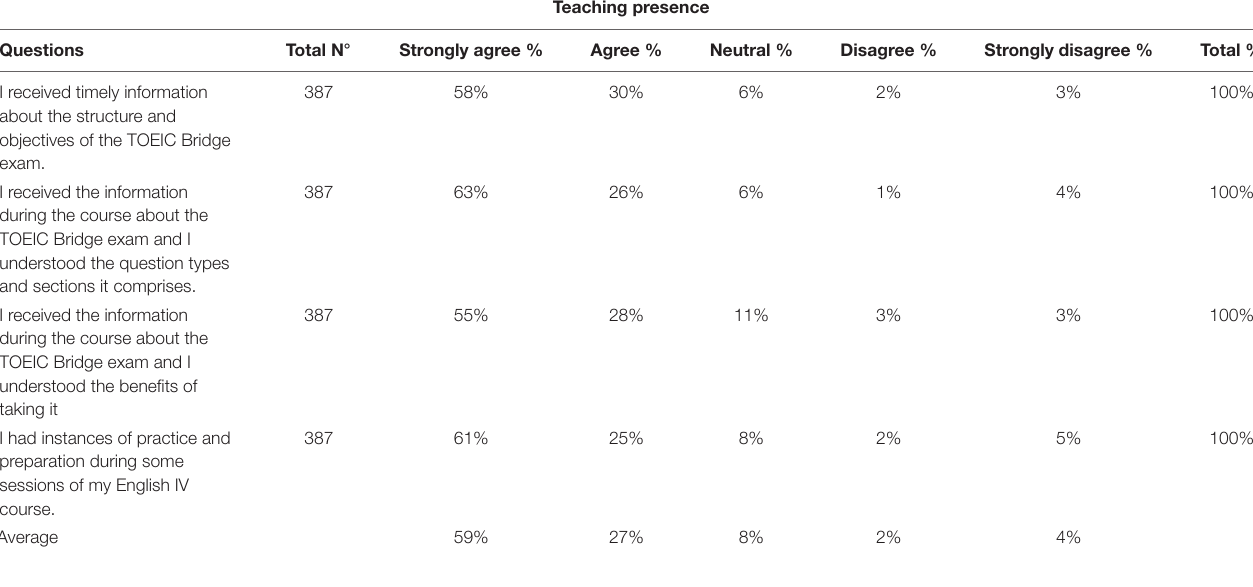
TABLE 4 | Survey results for teaching